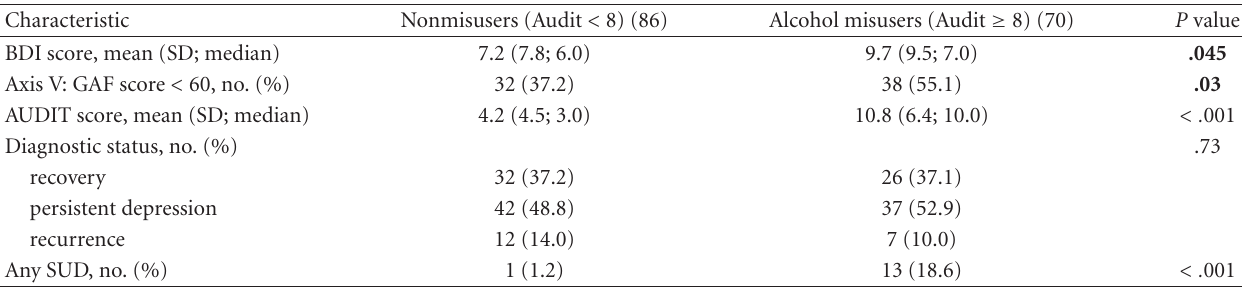
Table 3: Diagnostic and clinical characteristics of depressed outpatients at the one-year followup (by the alcohol use at baseline) n = 156.